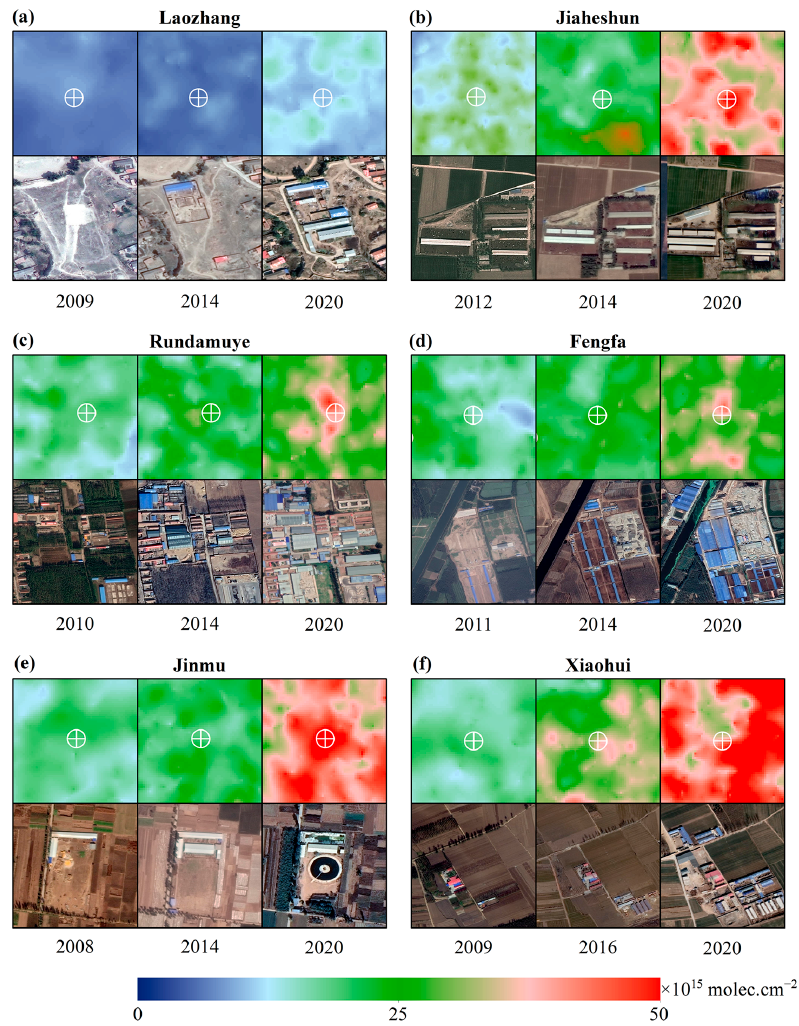
Figure 3. Changes in NH 3 columns and livestock farms. ( a – f ): the feedlots of Laozhang, Rundamuye, Fengfa, Jiaheshun, Jinmu and Xiaohui.